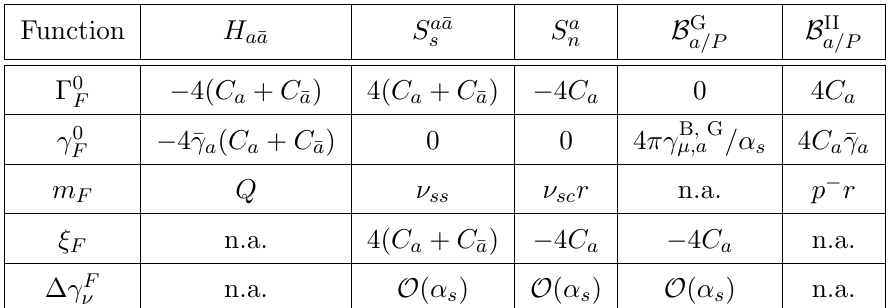
(cid:16) = ( (cid:11) ( (cid:22) ) C ) 2 ln( (cid:23)=p s F =(cid:25) (cid:22);a